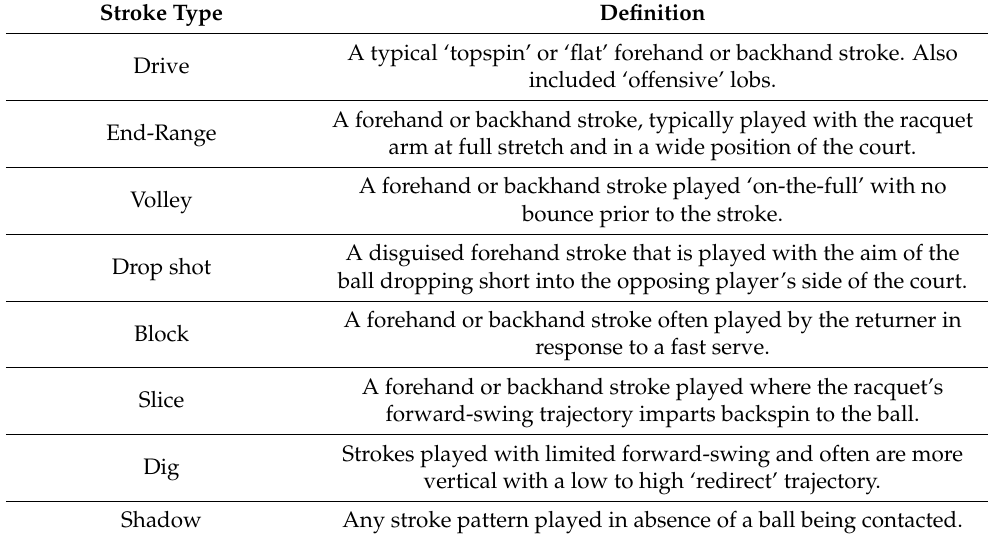
Table 1. Manually coded stroke